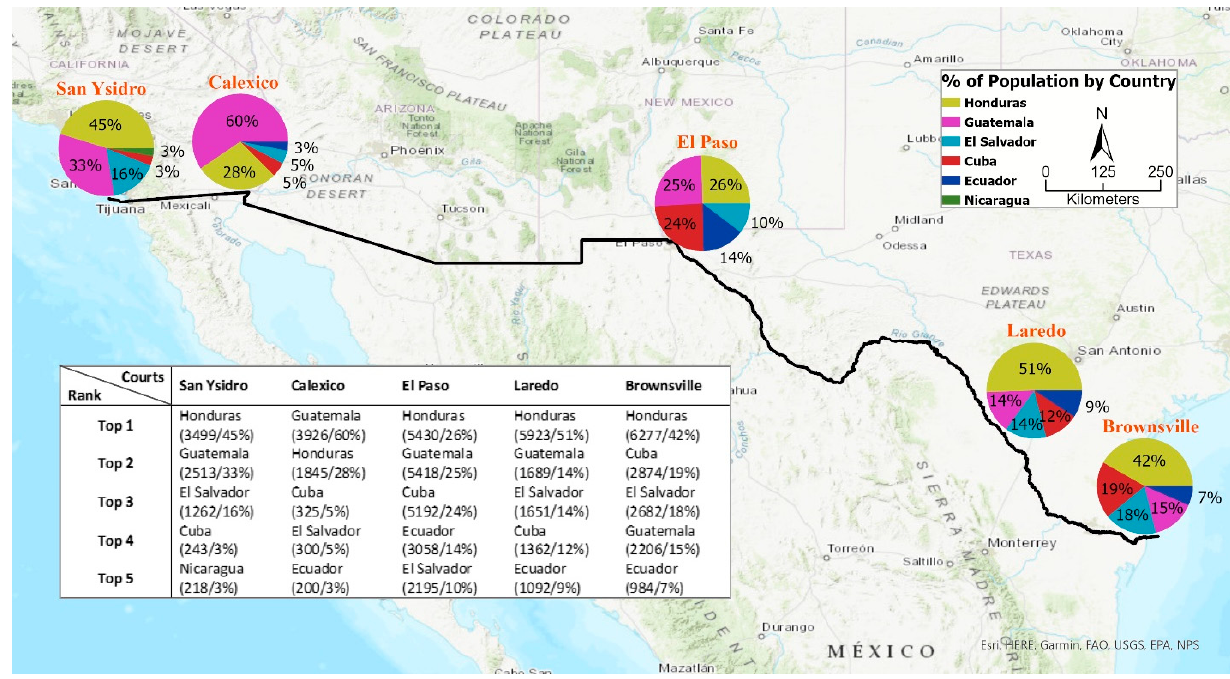
Figure 1. MPP court cases by top five nationalities along US-Mexico border. Data are through September 2020. Data source: Syracuse University (2020).